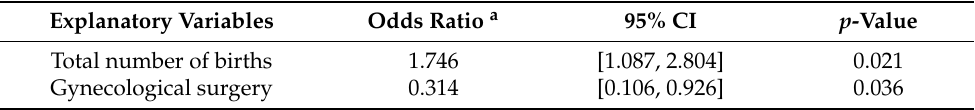
Table 3. Multivariate logistic regression analysis, with forward stepwise variable selection